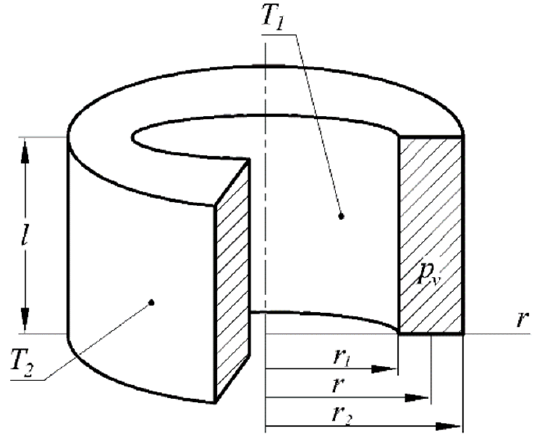
Figure 7. Variants of thermal replacement diagrams: ( a ) without heat emission and ( b ) with internal heat emission.